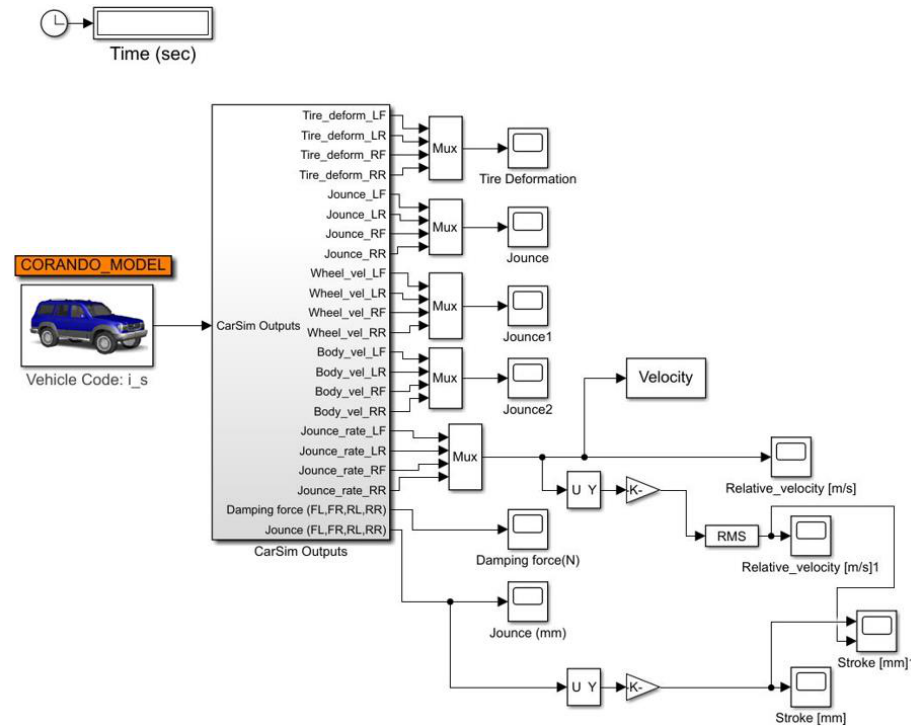
Figure 6. Block diagram.